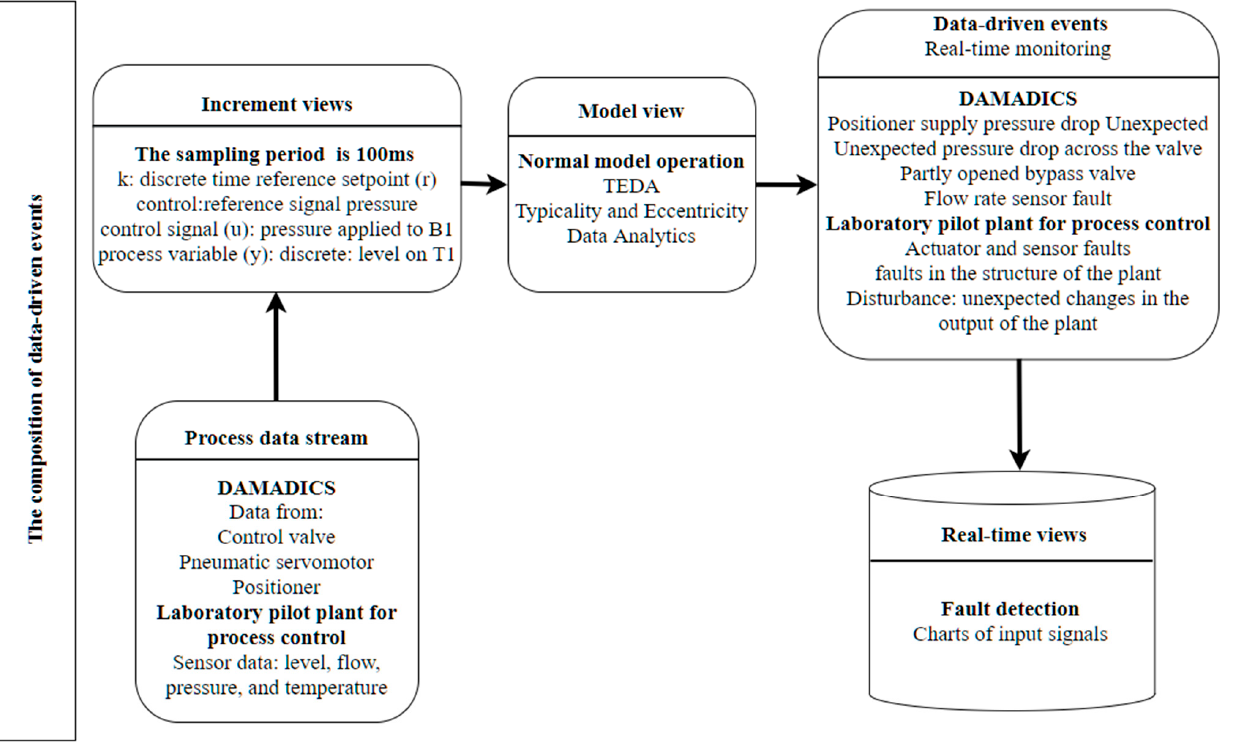
Figure 13. Instance of the real-time monitoring process for fault detection.